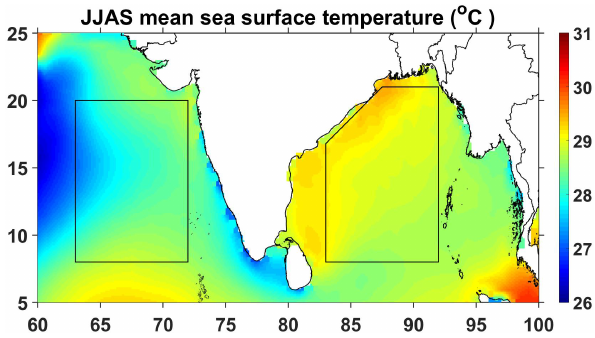
Figure 1. Spatial distribution of ISM mean SST (in ◦ C) obtained from ERA-Interim reanalysis data over the AS (8–20 ◦ N, 63–72 ◦ E) and the BOB (8–21 ◦ N, 83–92 ◦ E). The regions considered in this analysis over these two seas are shown with the boxes.